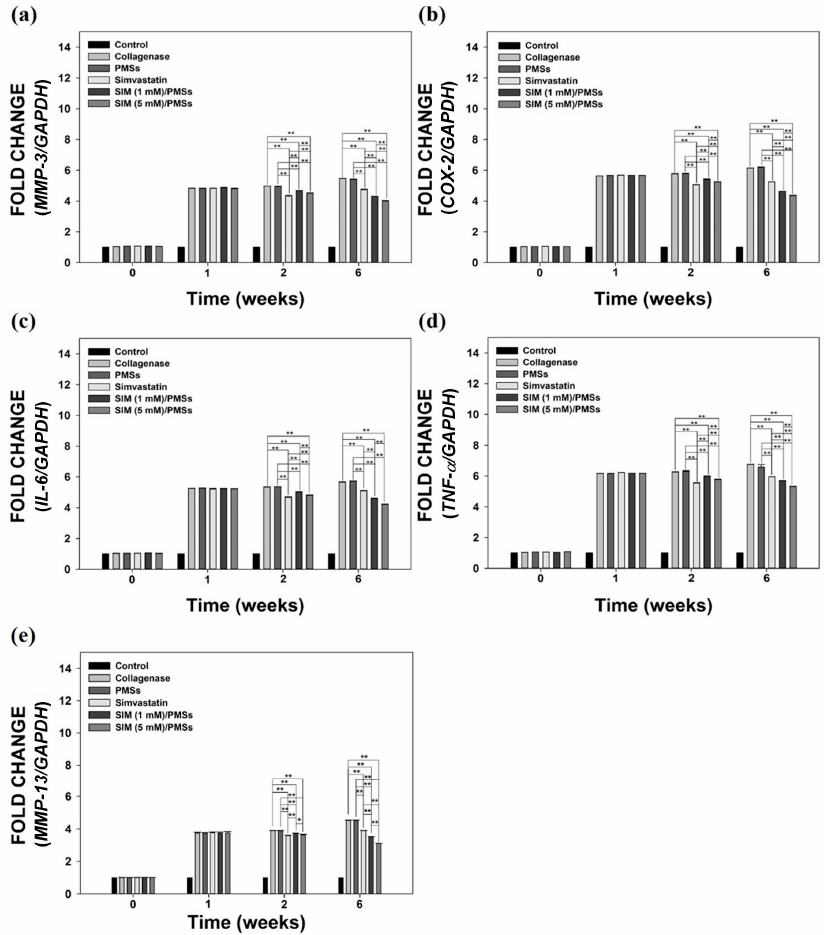
Figure 7. The relative mRNA expression levels of pro-inflammatory cytokines, including: ( a ) MMP-3 ; ( b ) COX-2 , ( c ) IL-6 , ( d ) TNF- α , and ( e ) MMP-13 in whole blood samples from a collagenase-induced Achilles tendinitis rat model in each group. Whole blood samples were collected from collagenase-induced Achilles tendinitis rat models in each group at 0, 1, 2, and 6 weeks after treatments with PMSs, simvastatin, SIM (1 mM)/PMSs, and SIM (5 mM)/PMSs. Each mRNA expression level was determined using real time-PCR analysis. Data represent means ± SDs ( n = 4), (* p < 0.05 and ** p < 0.01).